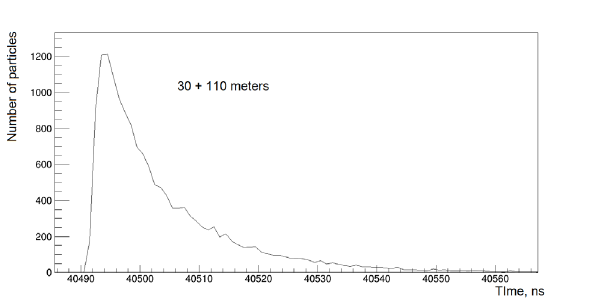
Figure 14. Two EAS disks side-by-side. Detector is 30 m from axis of one disk and 110 m from axis of another.